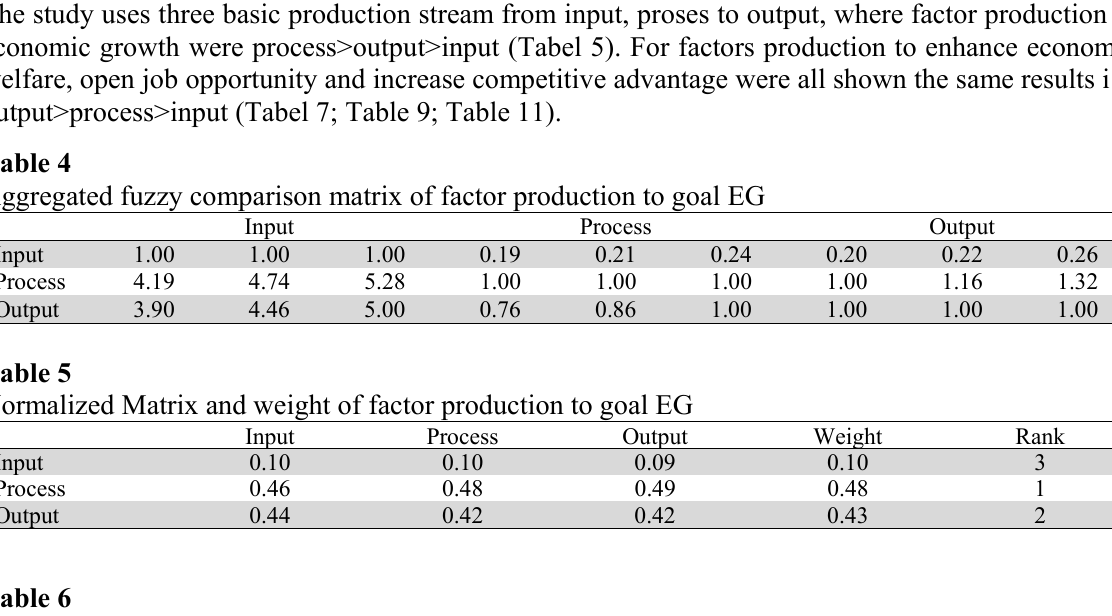
Aggregated fuzzy comparison matrix of factor production to goal ECW Input Process Output